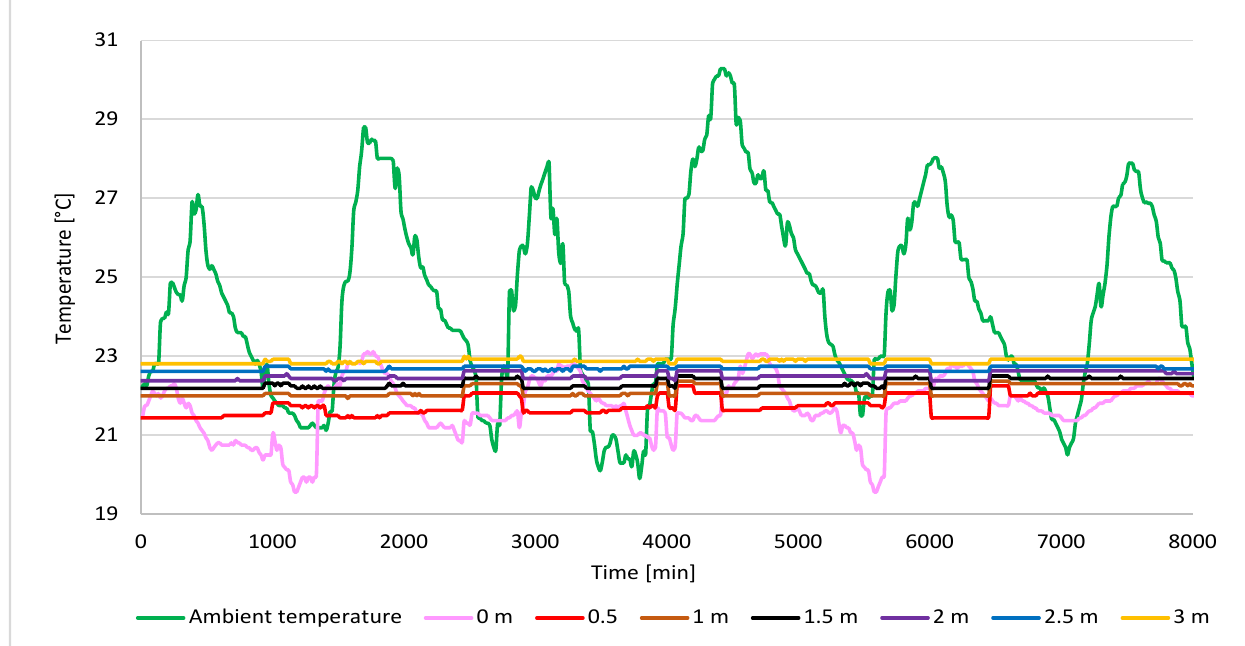
Figure 9. Soil temperature measured at different depths.